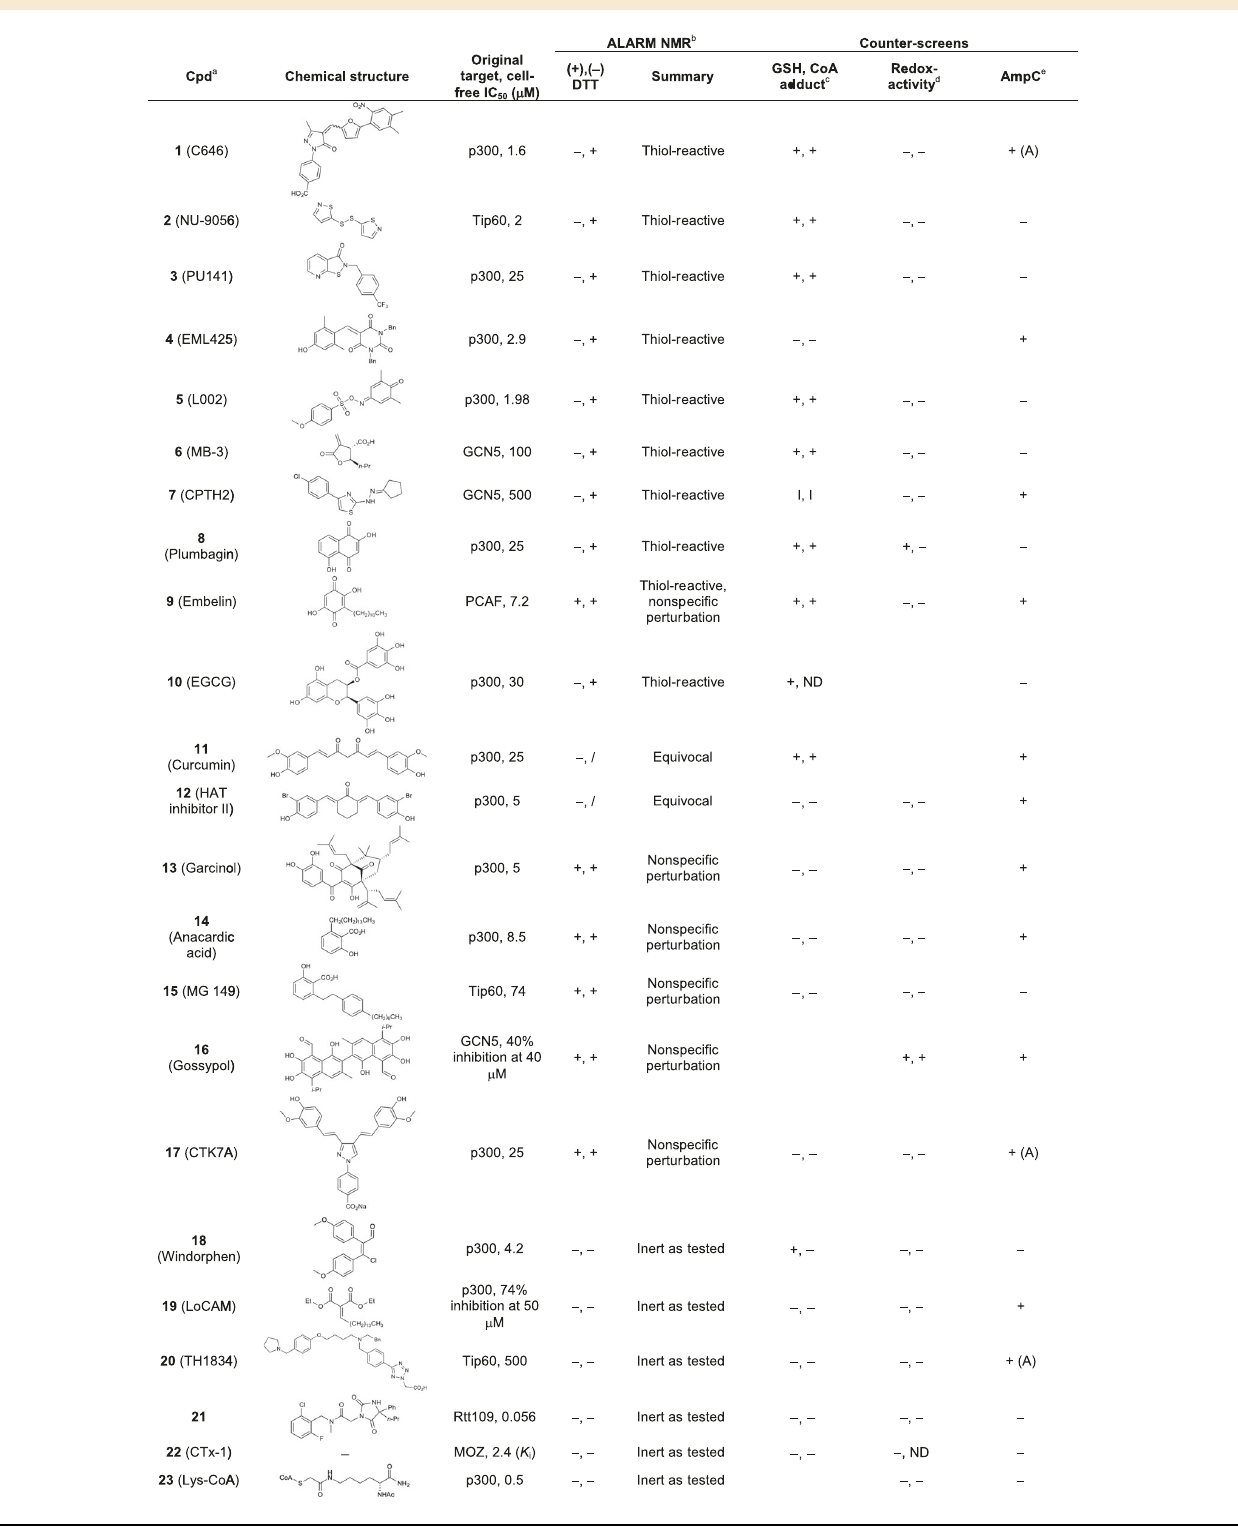
Table 1 Summary of assay interference for reported HAT